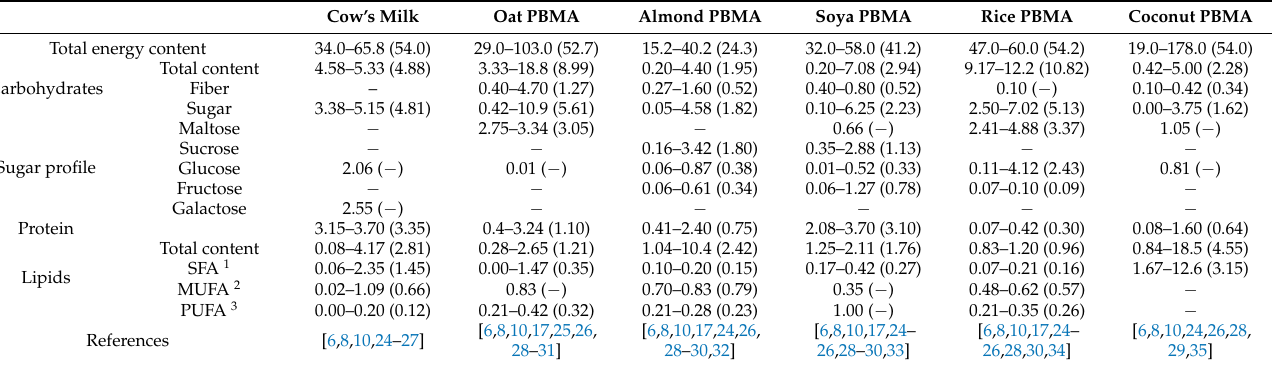
Table 1. Nutritional composition (energy expressed as kcal/100 mL and macronutrients expressed as g/100 mL) of cow’s milk and some (oat, almond, soya, rice, and coconut) plant-based milk alternatives (PBMA). The data is presented by the range and the average in